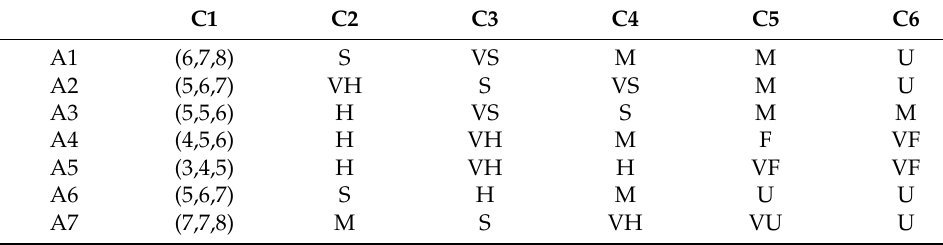
Table 3. Evaluation of alternatives by E2.